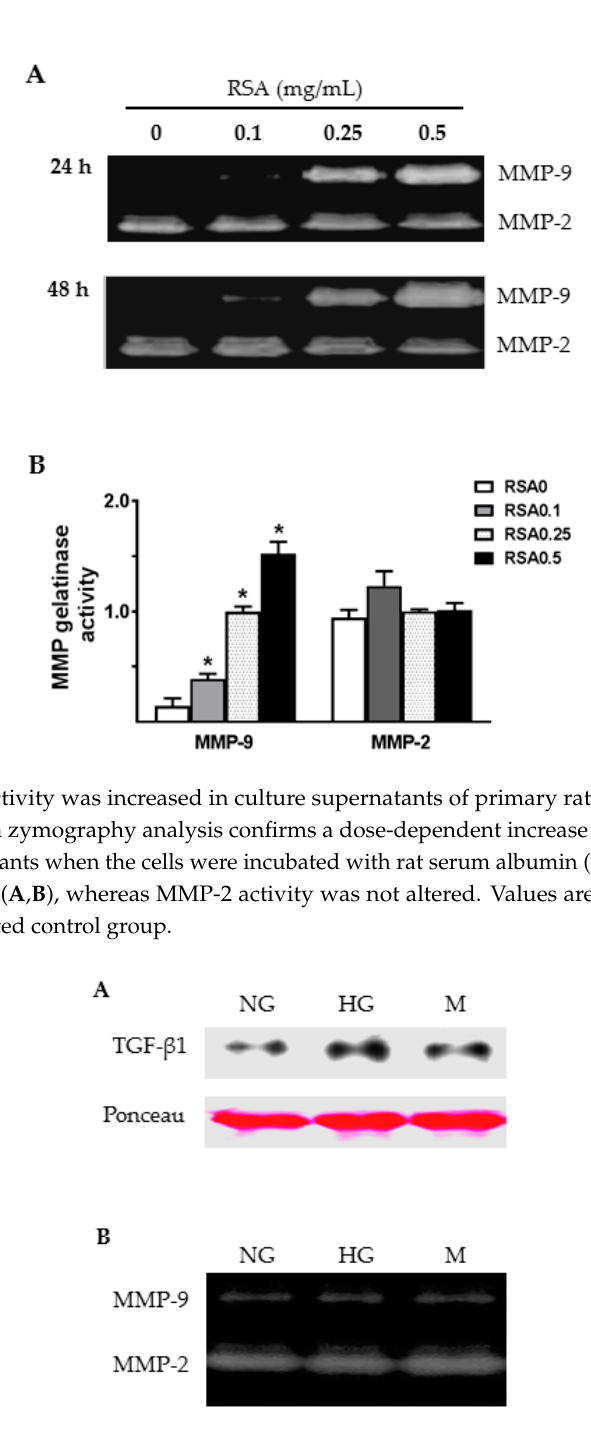
Figure 8. Effect of high glucose on secretion TGF- β 1 and MMP-9 by primary rat TECs. ( A ) Representative Western blotting images show TGF- β 1 protein in culture supernatants of TECs treated with normal glucose (NG), high glucose (HG) and mannitol (M) for 24 h. Ponceau red staining was used as loading control; ( B ) Gelatin zymograph shows MMP-2 and MMP-9 activities in culture supernatants of TECs treated with normal glucose, high glucose, or mannitol for 24